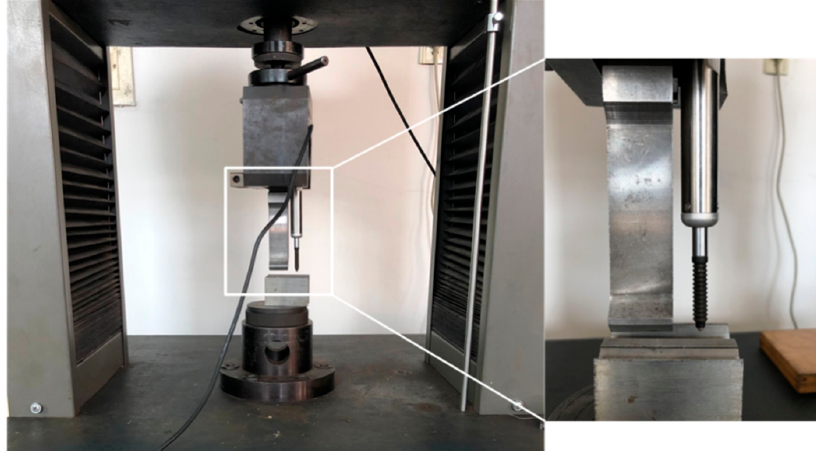
Figure 9. Bending experiment with the universal testing machine.